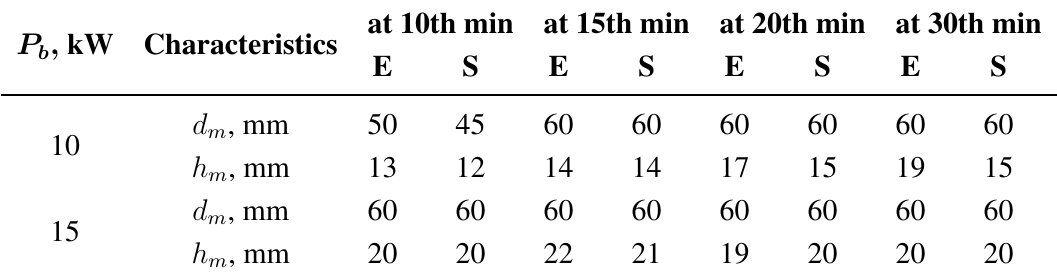
Table 2. Experimental and simulation data about the geometry of the molten pool during EBMR of copper. E—experimental data; S—simulation